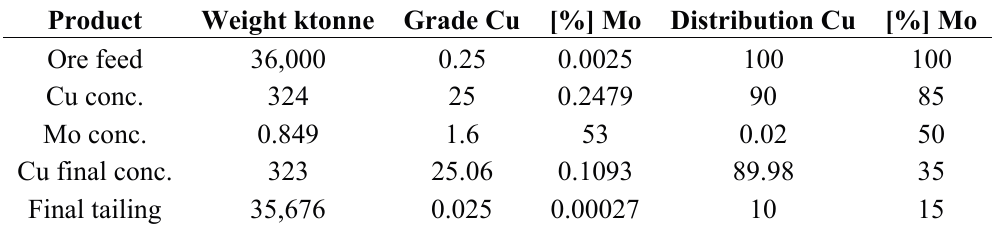
Table 3. Mass balance prognosis for molybdenum concentrate production at Aitik. Product Weight